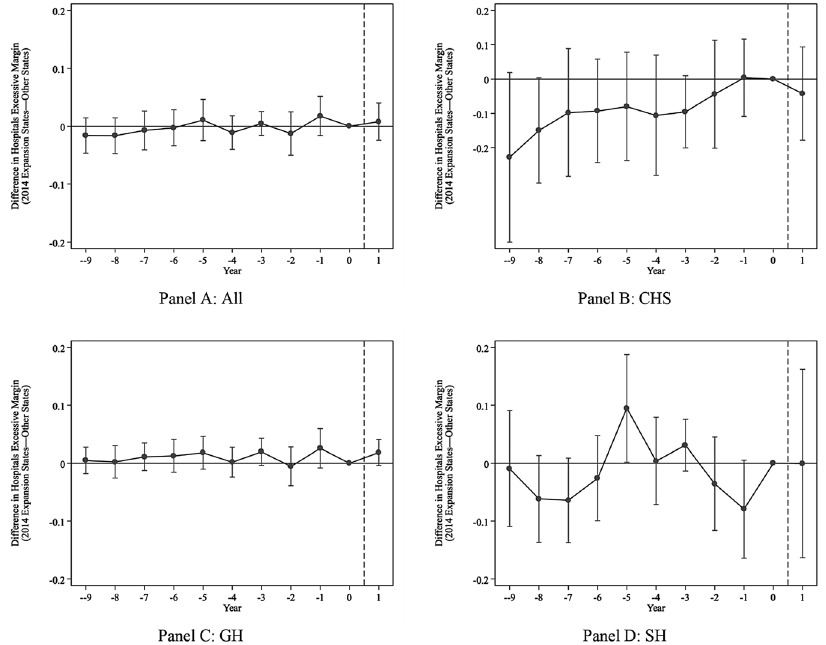
Figure3: Differencesintheexcessmarginbetweentheexpansionstatesandthenon-expansion